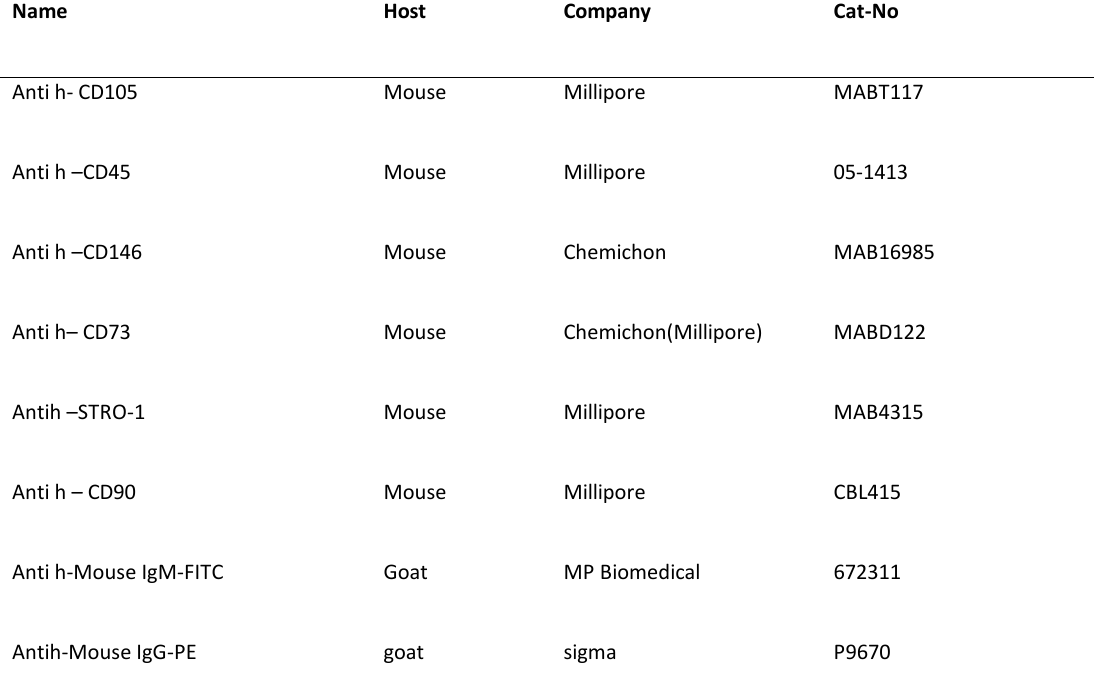
Table 1. Antibodies used for identification of mesenchymal cells